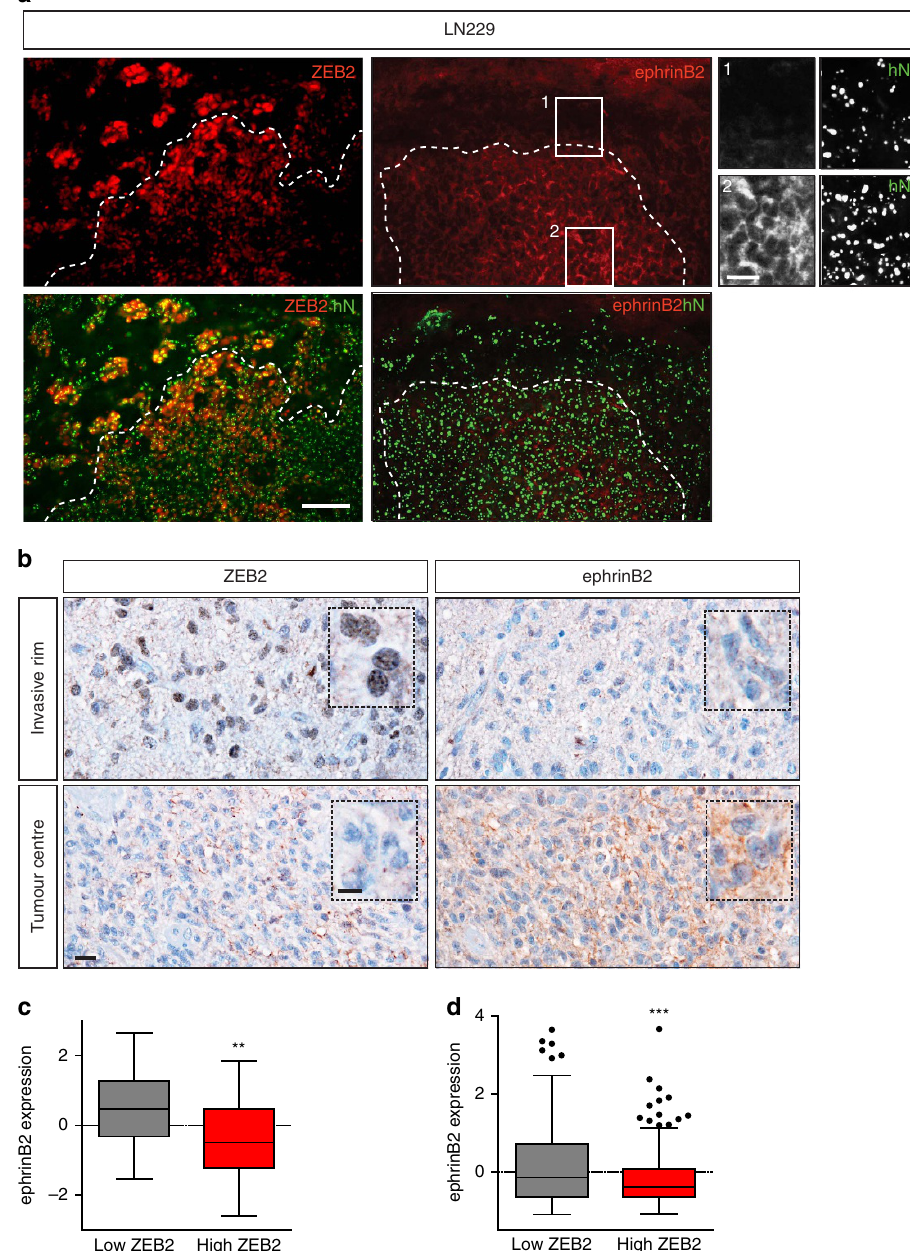
Figure 5 | ZEB2 is upregulated and ephrinB2 downregulated at the invasive front of glioblastoma xenografts and human patients. ( a ) Immunofluorescence analysis of ZEB2 and ephrinB2 expression at the invasive tumour rim of highly invasive intracranial LN229 glioblastoma xenografts (red: anti-ZEB2, anti-ephrinB2; green: anti-human nuclei (hN) (tumour cells)). ( b ) ZEB2/ephrinB2 expression in human glioblastoma biopsies. Immunohistochemical analysis of ZEB2 and ephrinB2 expression at the invasive tumour rim and tumour centre of human glioblastoma biopsies (red-brown: ZEB2, ephrinB2; blue: nuclear counterstain hematoxylin). ( c , d ) The expression of ZEB2 and ephrinB2 is inversely correlated in human gliomas. EphrinB2 expression is higher in gliomas with ZEB2 expression below the median (low ZEB2) compared with gliomas with ZEB2 expression higher or equal to the median (high ZEB2), in our glioma cohort 22 ( c , n ¼ 58 gliomas, expression values are log2 tumour/normal ratios), as well as in tumors of The Cancer Genome Atlas (TCGA) cohort ( d , n ¼ 530 gliomas, expression values are RNA-seq z-scores). The box-and-whiskers plots are drawn according to the method of Tukey. ** P o 0.01, *** P o 0.001 using Student’s t -test. Scale bars, 100 m m ( a ); 20 m m ( b and insets in a